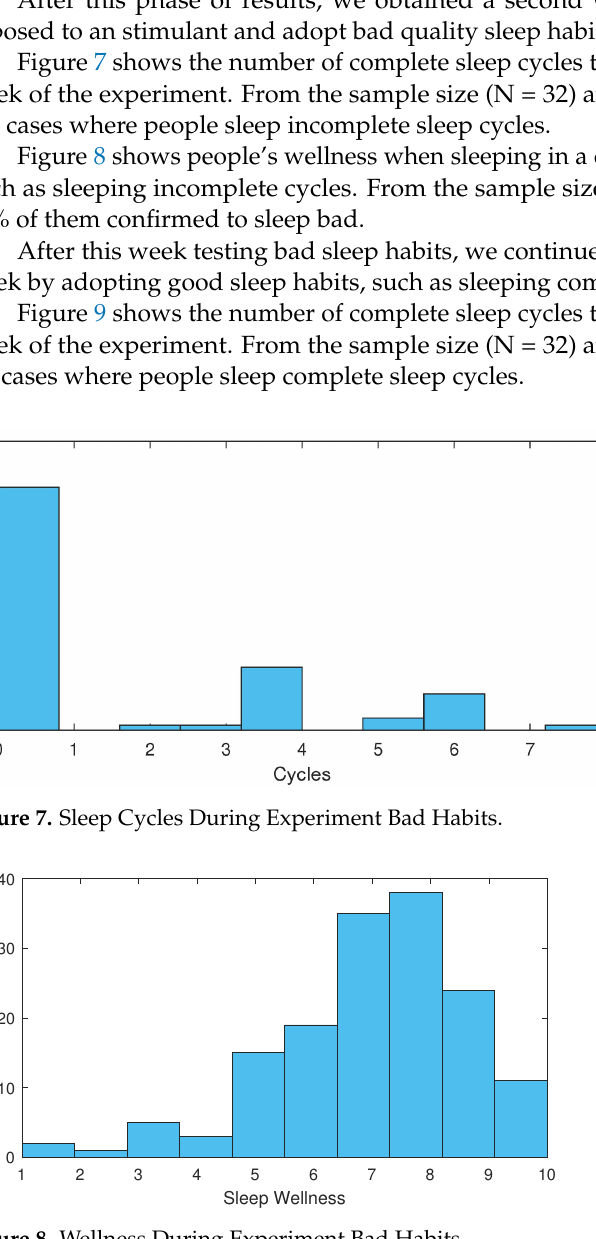
Figure 8. Wellness During Experiment Bad Habits.